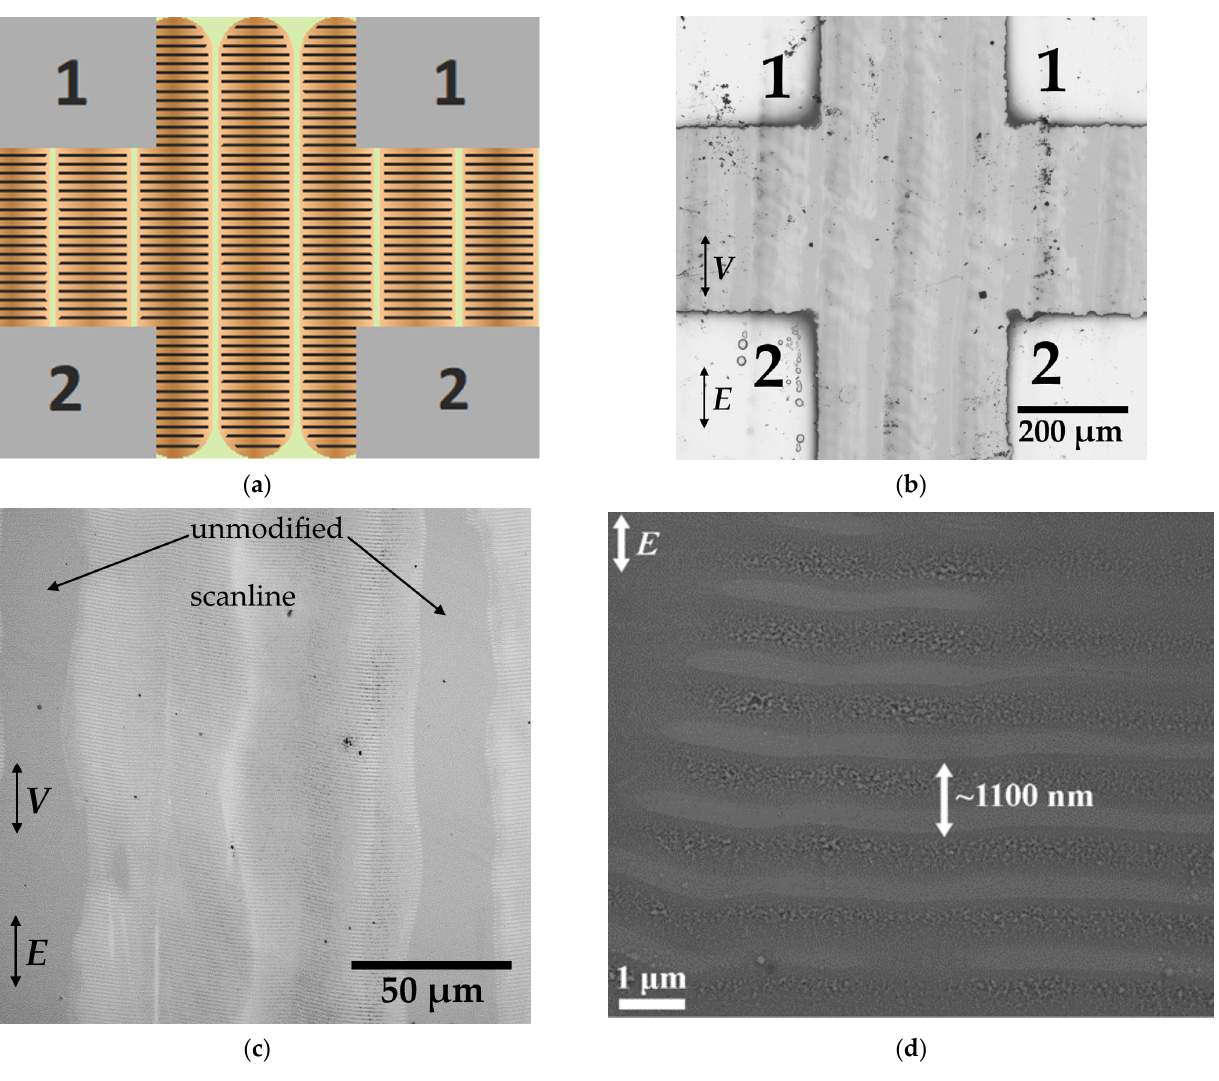
Figure 1. Scheme of the studied sample, where the gray areas illustrate the deposited aluminum electrodes for the electrophysical measurements; scanlines are depicted by vertical brown stripes, and the LIPSS within them are indicated by black horizontal shading ( a ). OM image of the fabricated sample with the deposited aluminum contacts ( b ); OM image ( c ) and SEM micrograph image ( d ) of irradiated surface of the sample. Numbers 1 and 2 in subfigures ( a ) and ( b ) mark electrodes for electrophysical measurements: the applied current may be flow between electrode pairs 1–1 or 1–2.